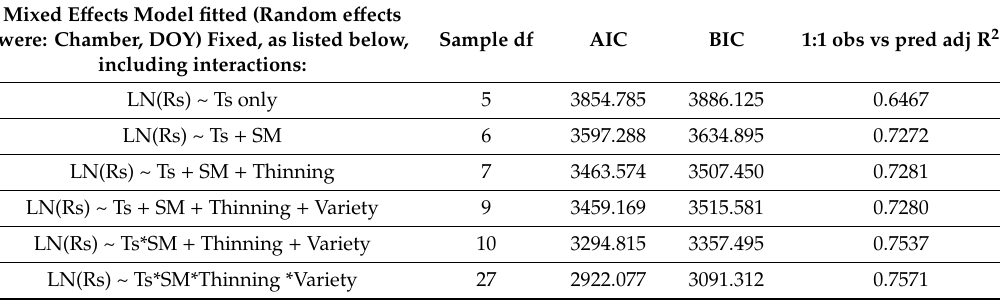
Table A1. Comparison of various model fits for the observed soil flux data. Mixed E ff ects Model fitted (Random e ff